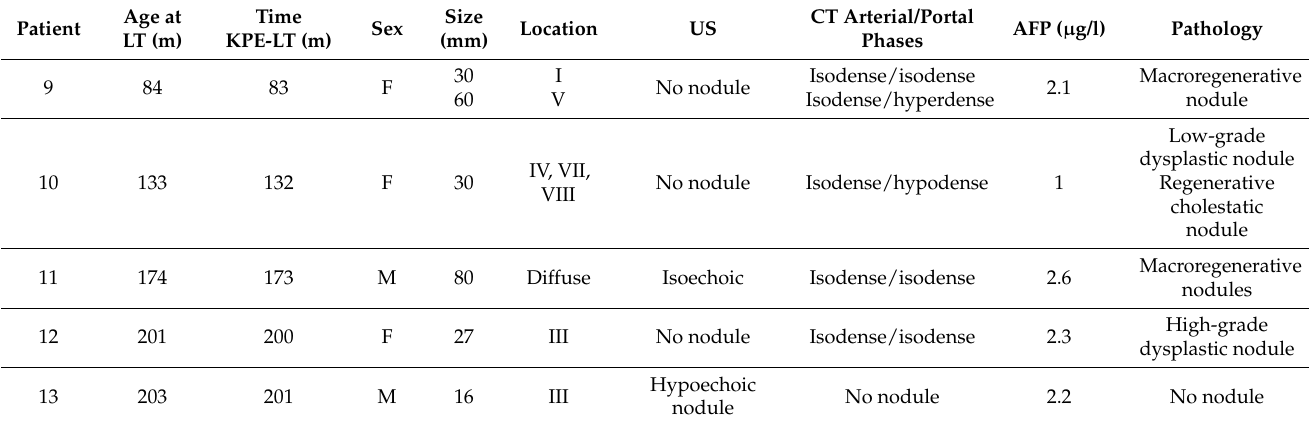
Radiological findings in 7/13 (54%) patients correlated with the final histological diagnosis: one patient with FNH and 6 with regenerative nodules (Figure 1).